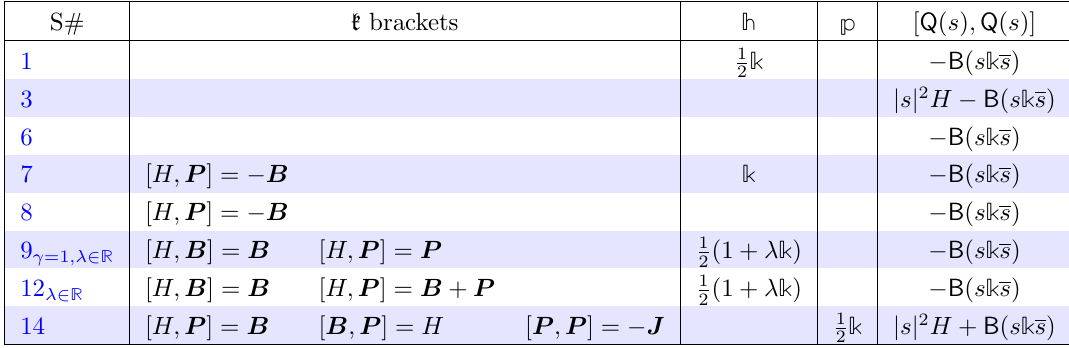
Table 10 . Super Lie pairs (with V = P